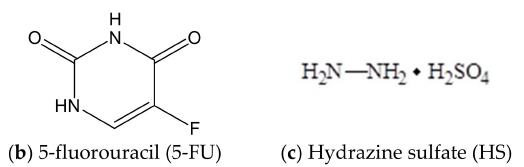
Figure 1. Formulas of components of combination drugs